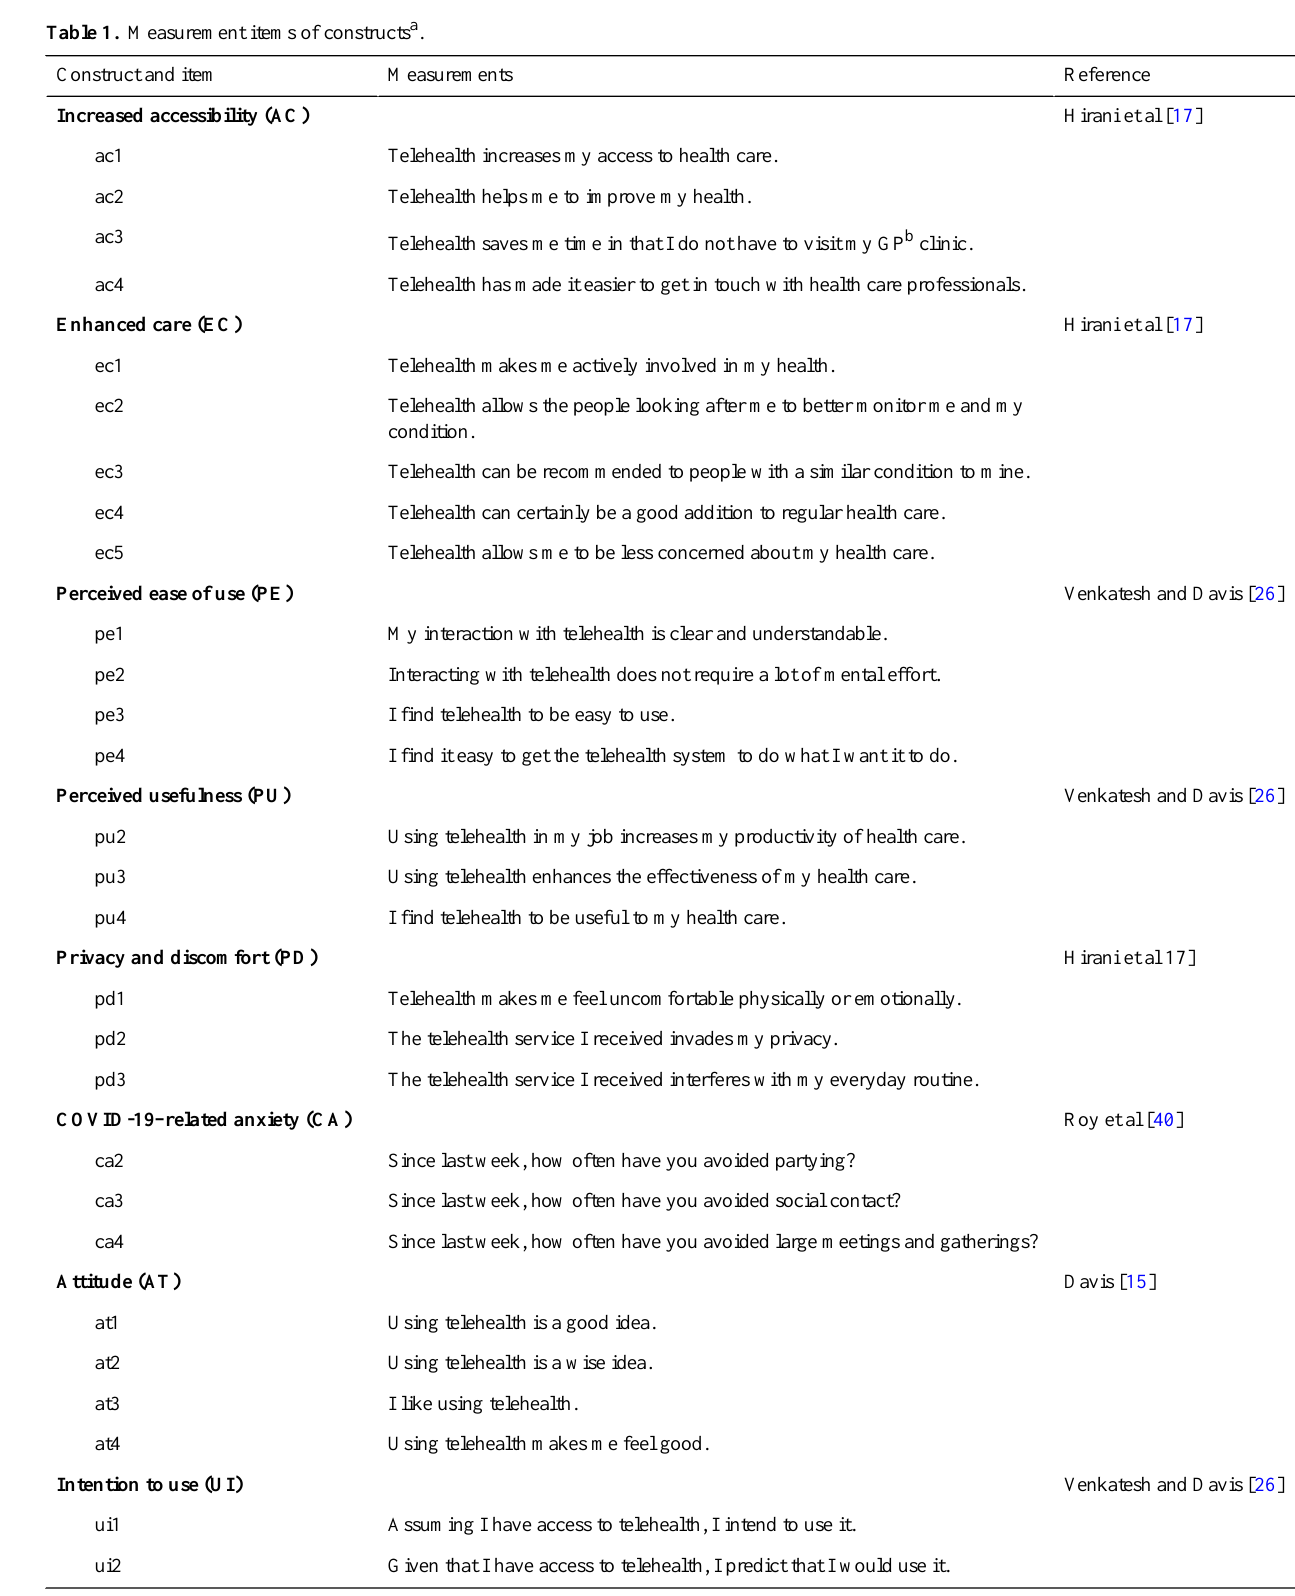
and 5=always. b GP: general